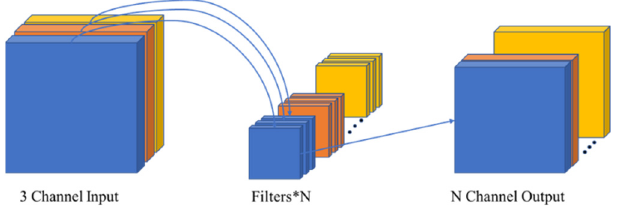
Figure 1. Standard convolution operation.